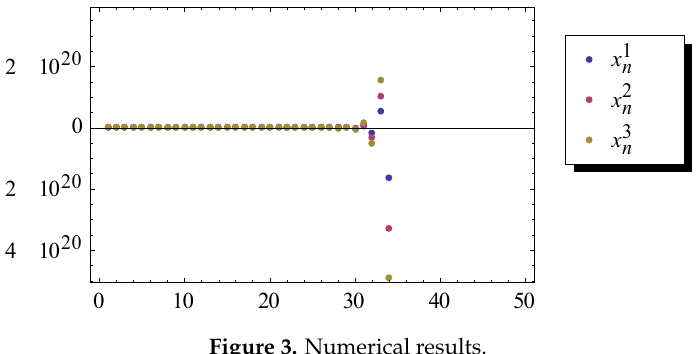
Figure 3. Numerical results.